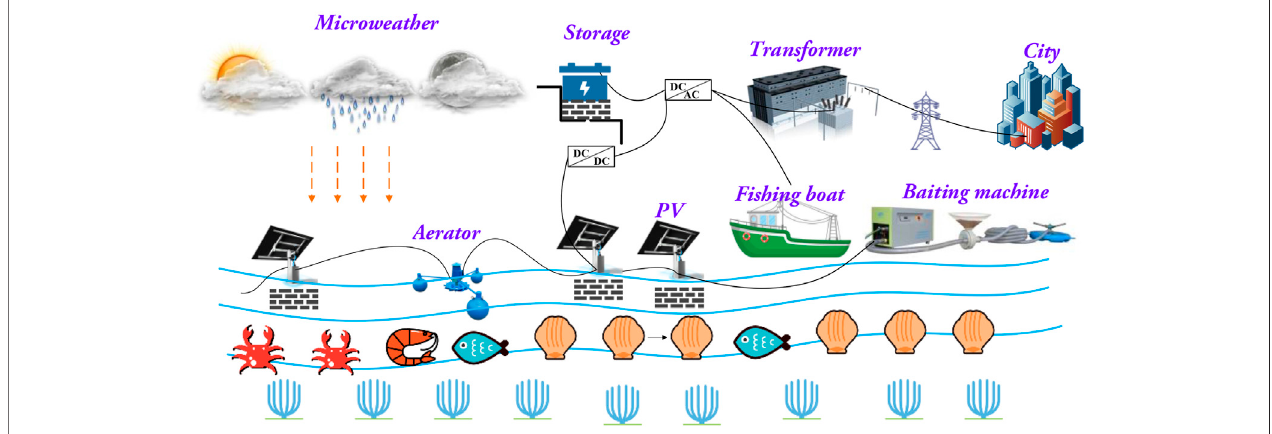
FIGURE 1 | Typical FEI consisting of fi shery electri fi cation demand and renewable energy